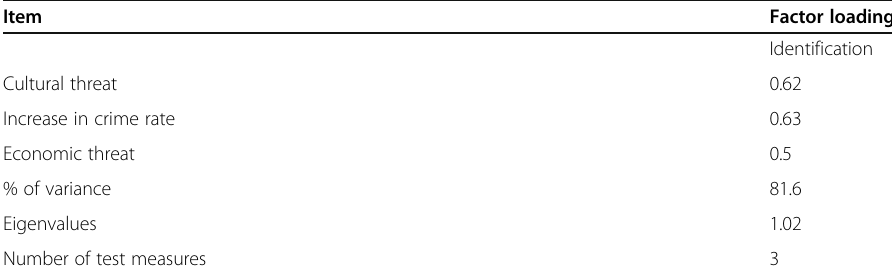
Table 2 Exploratory factor analysis results for